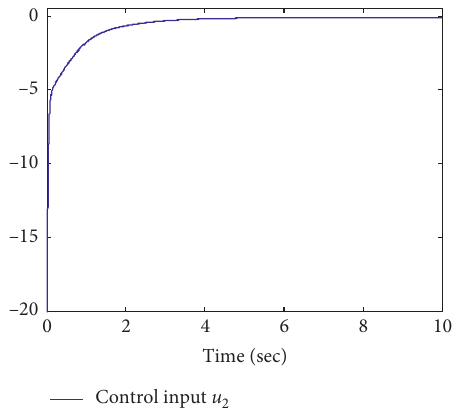
Figure 8: Control input u